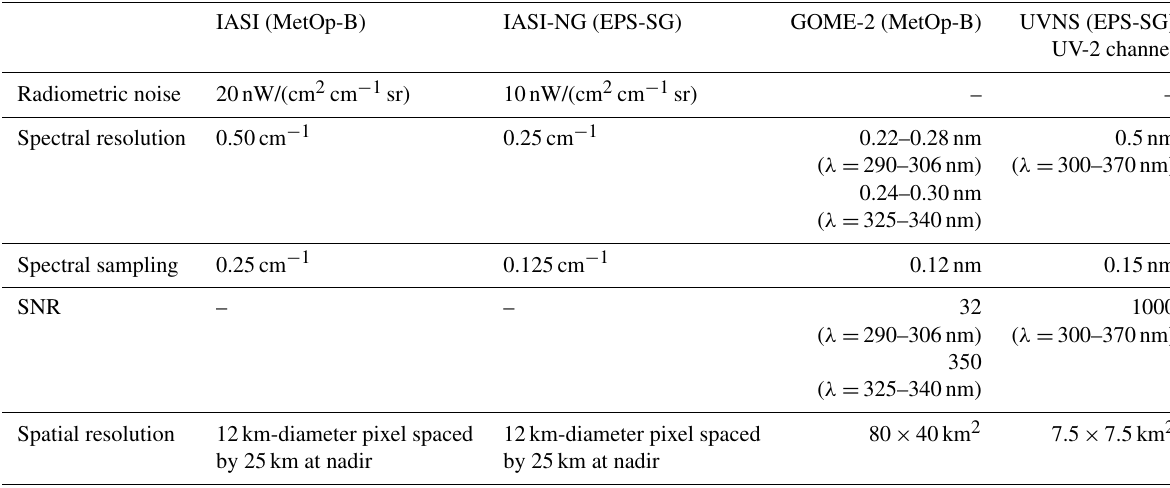
Table 1. Differences in nominal specifications of IASI-NG and UVNS (EPS-SG) with respect to IASI and GOME-2 (MetOp-B). For UVNS, only the UV-2 spectral channel is